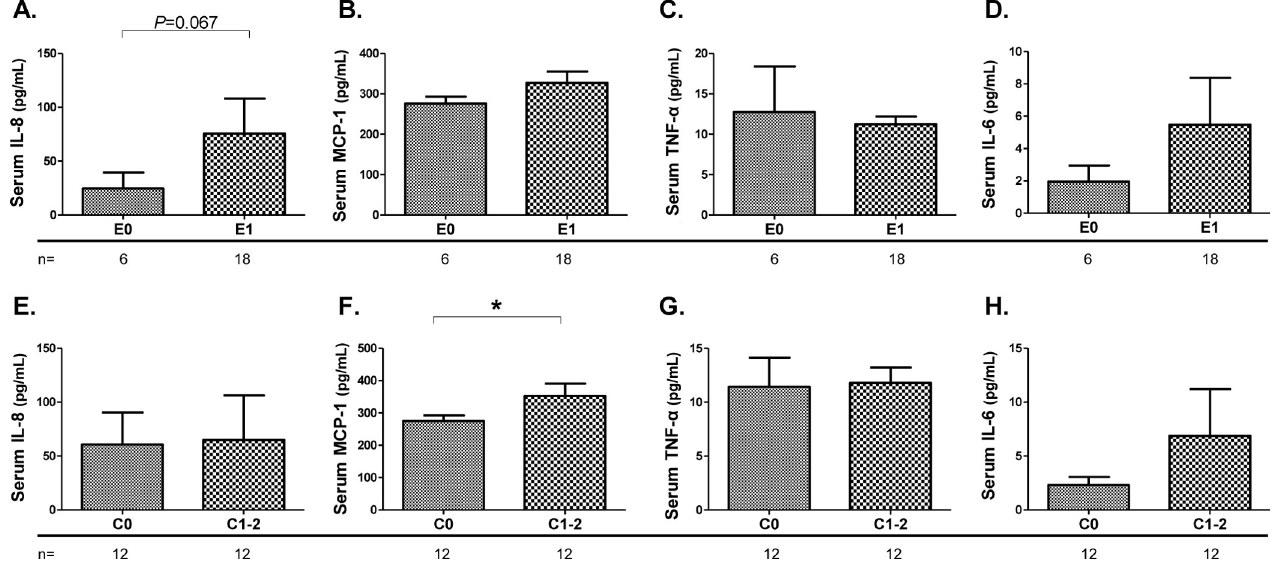
Fig 3. Comparisons of serum inflammatory cytokines among groups based on the Oxford classification of patients with HSPN. Comparison of serum IL- 8 ( A and E ), MCP-1 ( B and F ), TNF- α ( C and G ), and IL-6 ( D and H ) in patients with HSPN according to the presence of endothelial lesions or crescent formation based on the Oxford classification. Values are presented as means ± SEM. Data were statistically analyzed using Mann-Whitney U tests. � P < 0.05.